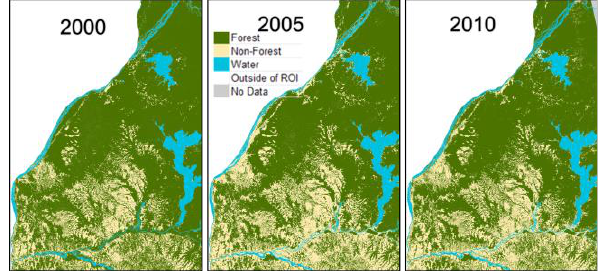
Figure 6. SAR-based FNF maps from ERS-2 SAR and Envisat ASAR WS for 2000 (a), Envisat ASAR WS for 2005 (b) and ALOS Palsar FBD/FBS for 2010